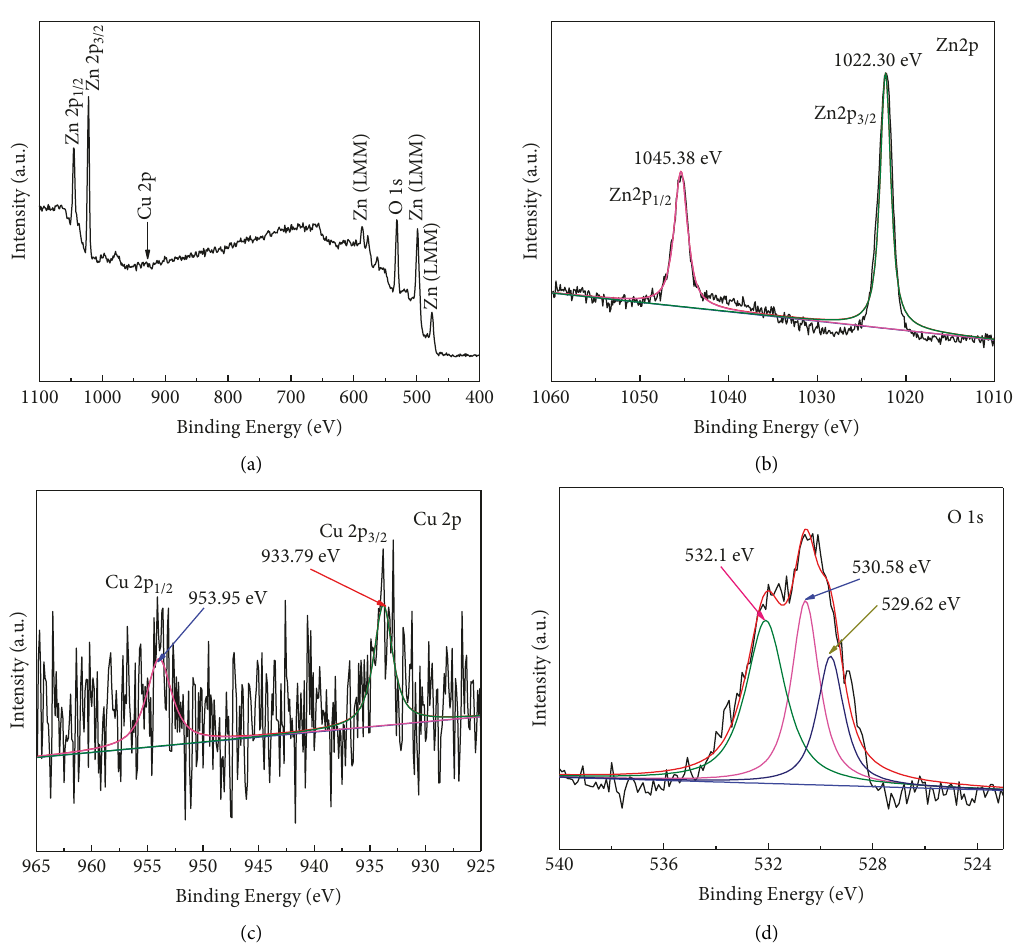
Figure 4: (a) XPS survey and spectra of (b) Zn 2p, (c) Cu 2p, and (d) O 1s for Cu-ZnO (3%) with plant extract.